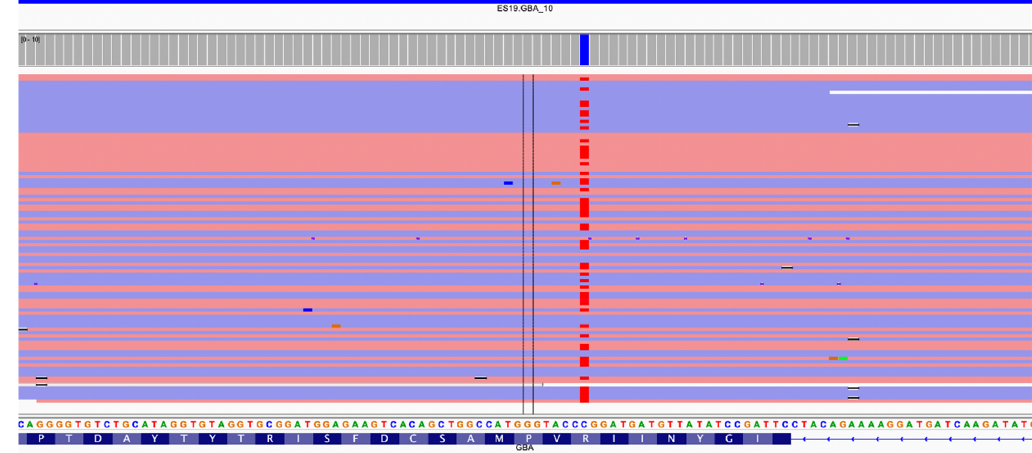
Figure 2. IGV (Integratice Genomics Viewer) visualization of the coverage analysis plugin for the amplicon ES19.GBA_10 covering the variant 476G>A (R120Q) for the sample NA10874. The variant is excluded by TVC because of the very low MQV (mapping quality value) of the reads due to the presence of a repeat.